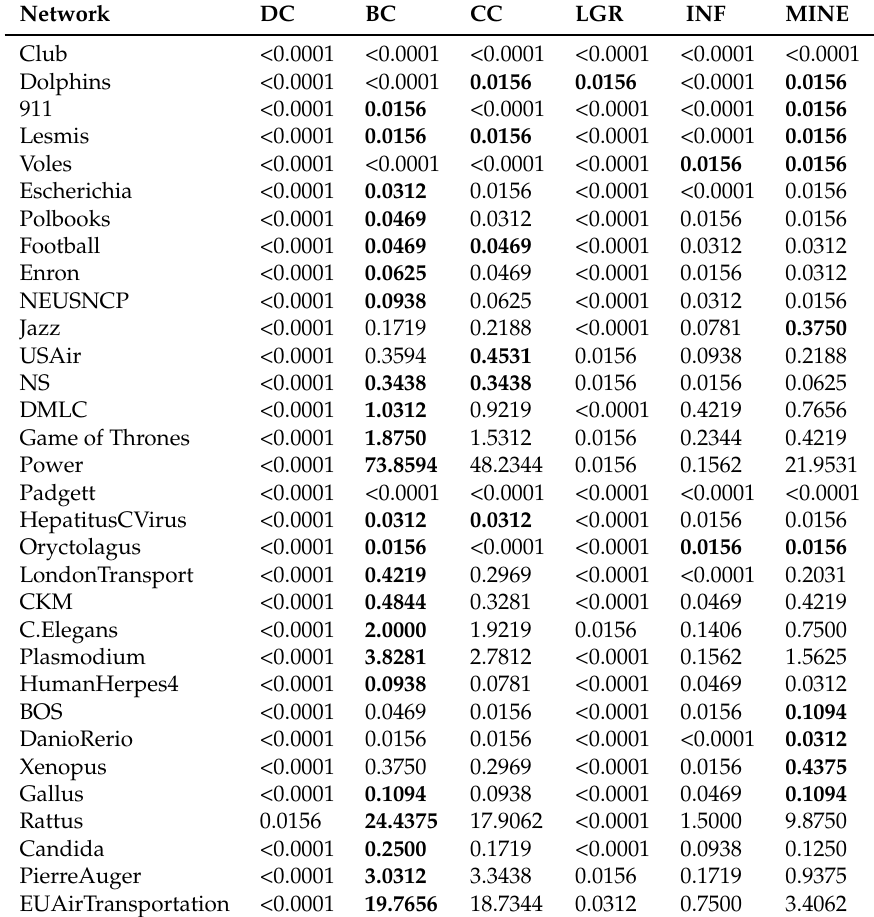
Table 4. Runtime comparison of DC, BC, CC, LGR, INF and MINE on 32 real-world